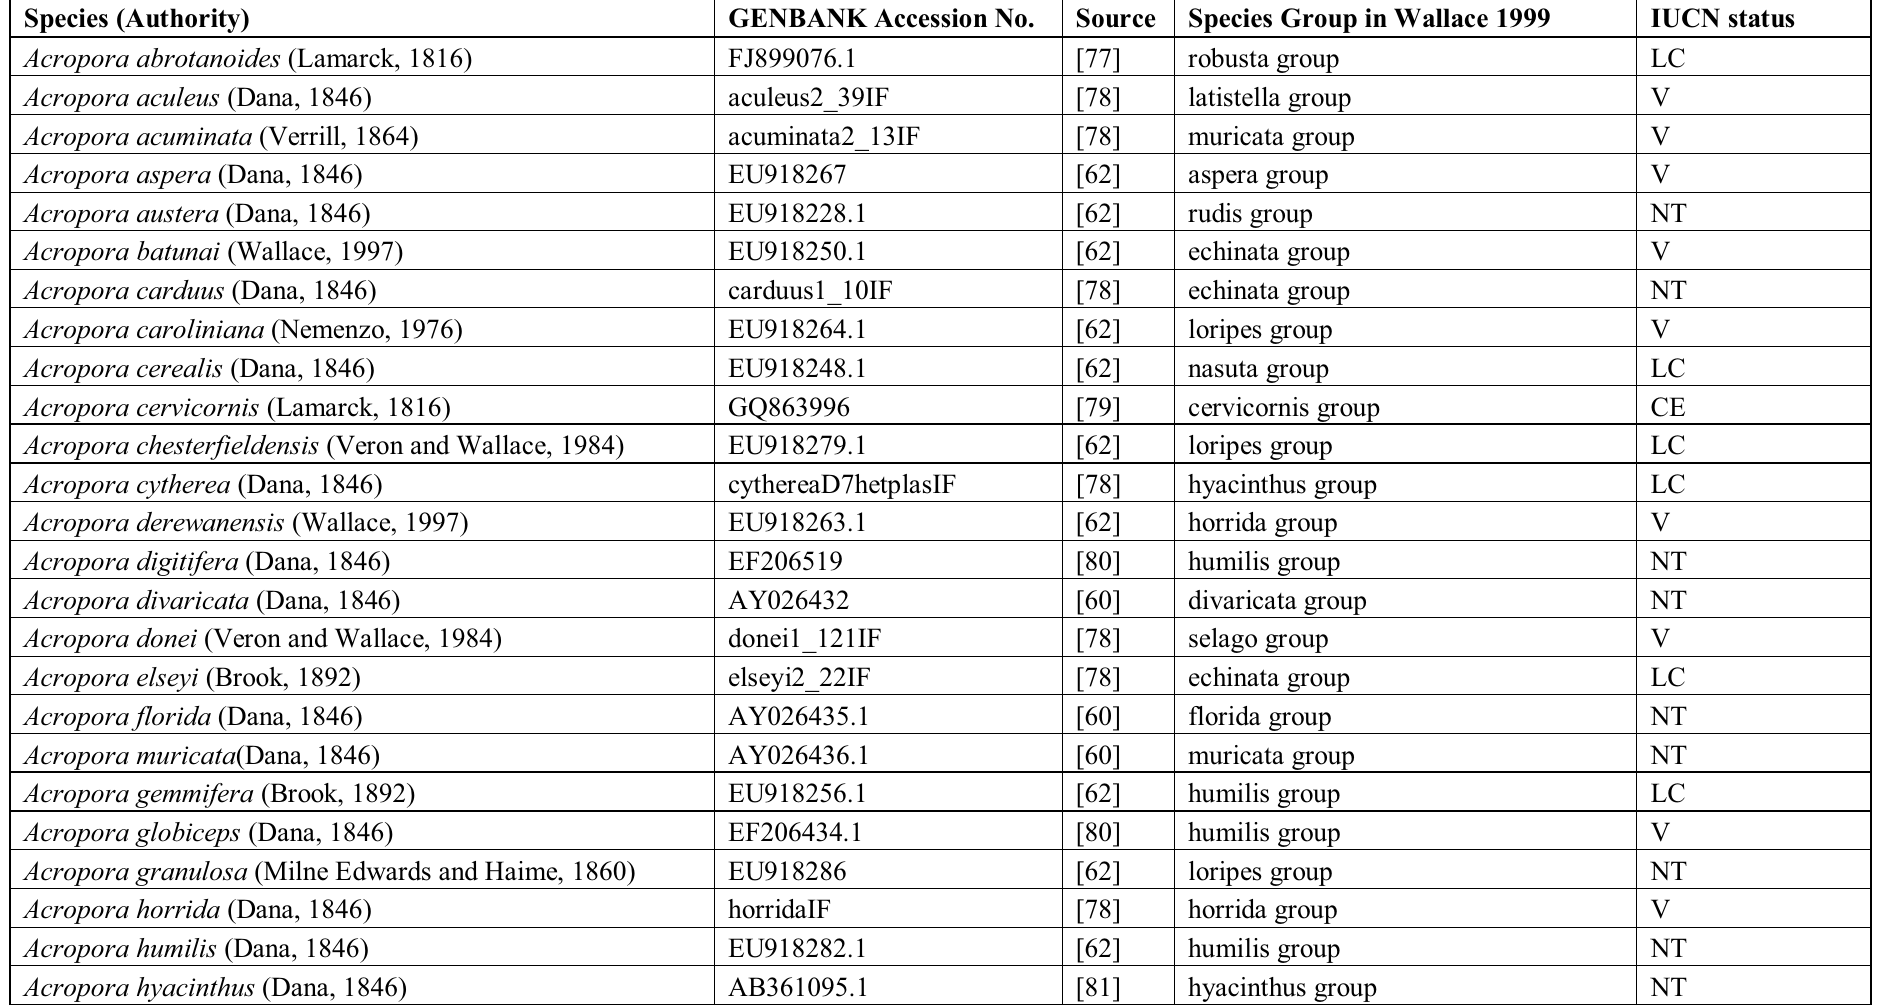
Table 2. Genbank Accession numbers and details of the 65 species included in the Acropora